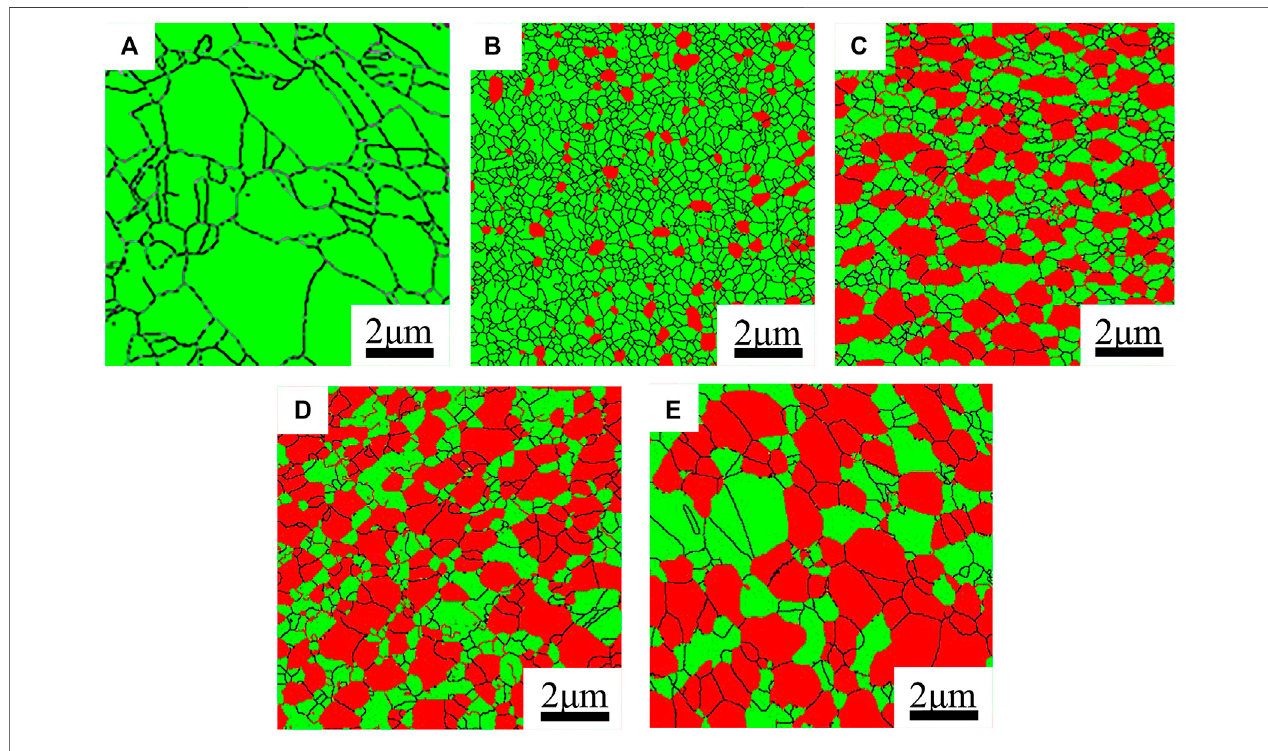
FIGURE 6 | EBSD phase maps of bulk FeCoNi(CuAl) x MEA and HEAs: (A) x (cid:1) 0; (B) x (cid:1) 0.4; (C) x (cid:1) 0.6; (D) x (cid:1) 0.8; (E) x (cid:1) 1.0 (green-FCC, red-BCC).